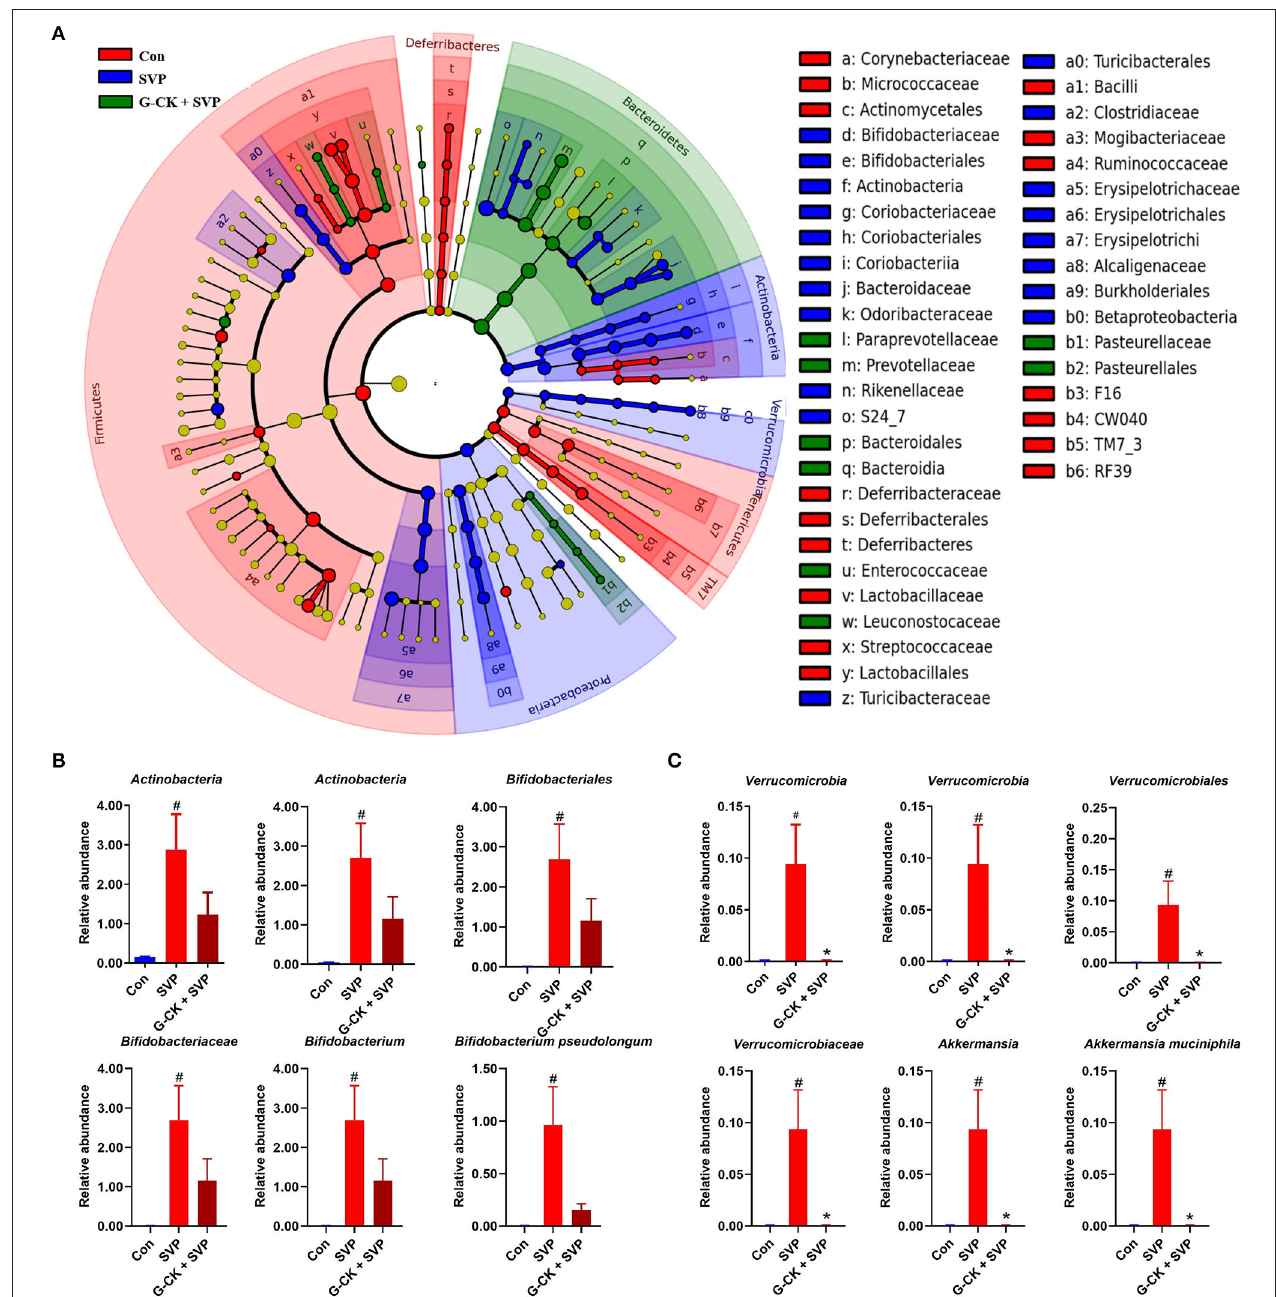
FIGURE 2 | LEfSe analysis of gut microbiota. (A) Cladogram representative. The red, blue, and green nodes in the phylogenetic tree represent microbial species that play an important role in the Con, SVP, G-CK + SVP groups, respectively. Yellow nodes represent species with no significant difference. (B) The relative abundance of Actinobacteria , Actinobacteria , Bifidobacteriales , Bifidobacteriaceae , Bifidobacterium , and Bifidobacterium pseudolongum. Values are mean ± SD, n = 10. (C) The relative abundance of Verrucomicrobia , Verrucomicrobiae , Verrucomicrobiales , Verrucomicrobiaceae , Akkermansia , and Akkermansia muciniphila . Values are mean ± SD, n = 10. Con, control; SVP, sodium valproate (500 mg/kg, twice daily); G-CK, ginsenoside compound K (320 mg/kg, once daily). # p < 0.05 vs. Con group, * p < 0.05 vs. SVP